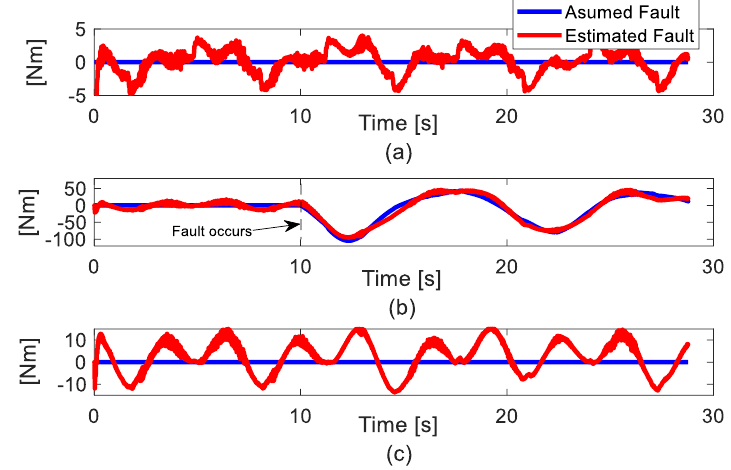
Figure 7. Fault estimation results. ( a ) Joint 1; ( b ) Joint 2; ( c ) Joint (3).